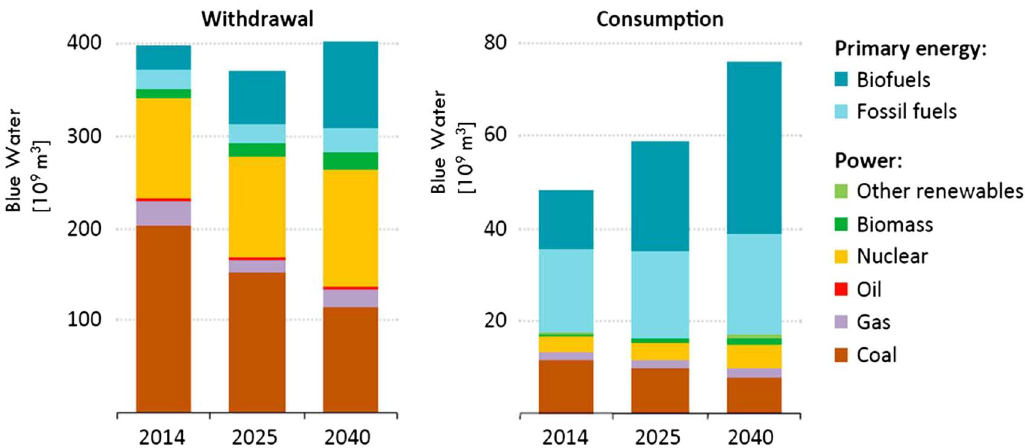
Figure 2. Water consumption and withdrawal for energy production 40